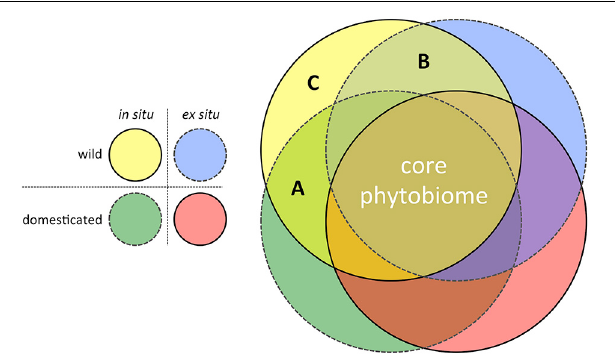
FIGURE 2 | Characterizing the phytobiome composition of replicated common gardens, consisting of wild and domesticated/improved genotypes, grown in both the center of diversity ( in situ ) and under agricultural conditions outside the center of diversity ( ex situ target environments), has the potential to identify the effects of both domestication and migration on the disruption of beneficial co-evolved crop-microbe associations. (A) Lost microbial associations due to migration of the host from the center of diversity (i.e., microbial associations still forged by modern crop genotypes, if the respective microbes are present = an inoculation opportunity); (B) Lost microbial associations due to host domestication (i.e., modern crop genotypes have lost the ability to forge these associations, even when the respective microbes are present = a breeding opportunity); and (C) Lost microbial associations due to both migration and domestication (i.e., both breeding and ambient microbiome modification would be required to restore these